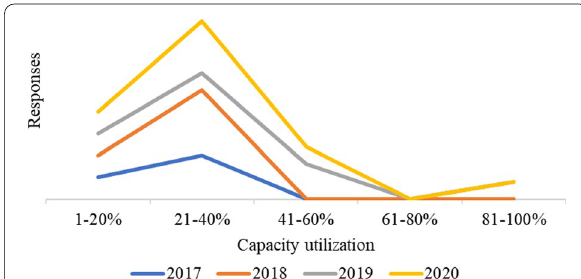
Fig. 3 Capacity utilization of tanneries and leather goods firms in